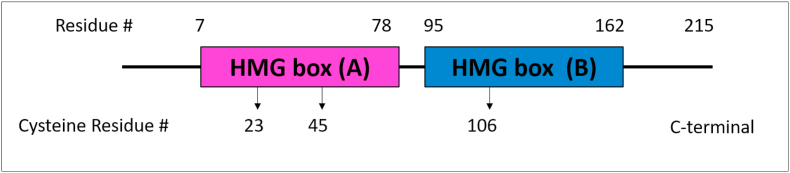
HMGB1 protein structure [11].